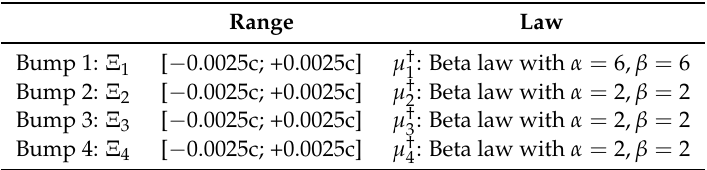
Figure 8. Picture depicting the lift C l and the drag C d of an airfoil. Table 1. Range of each input